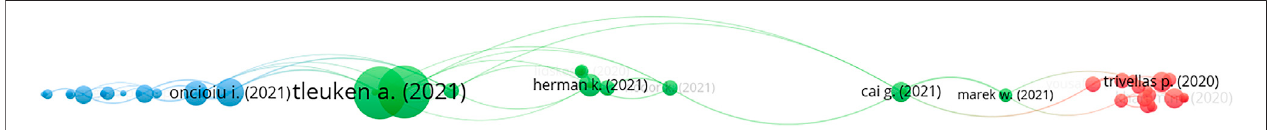
FIGURE 4 | Bibliometric coupling.